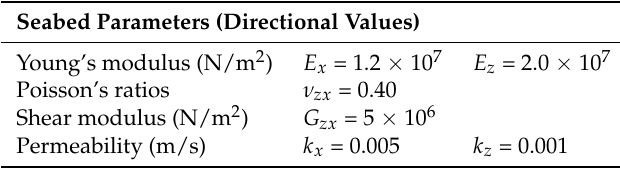
Table 1. Soil parameters for wave–structure–seabed interaction (e.g.,